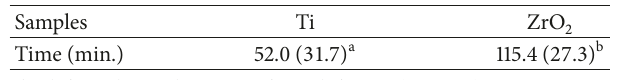
Table 1: Contact angle measurements of Ti and ZrO 2 sensors (mean ± SD 𝑛 = 3 ). Samples